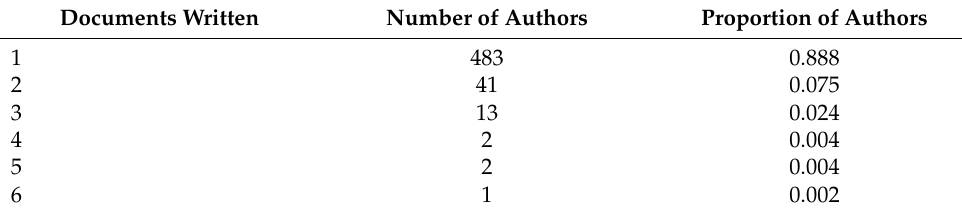
Table 6. Distribution of authors’